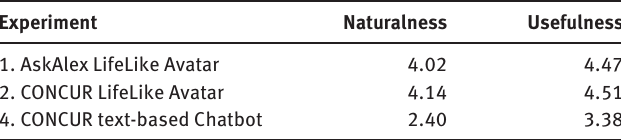
Table 6. Survey Results for Naturalness and